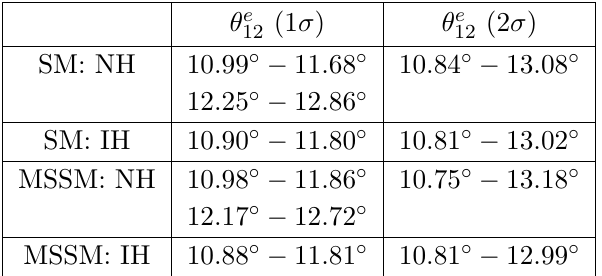
which predict the correct experimental value for 12